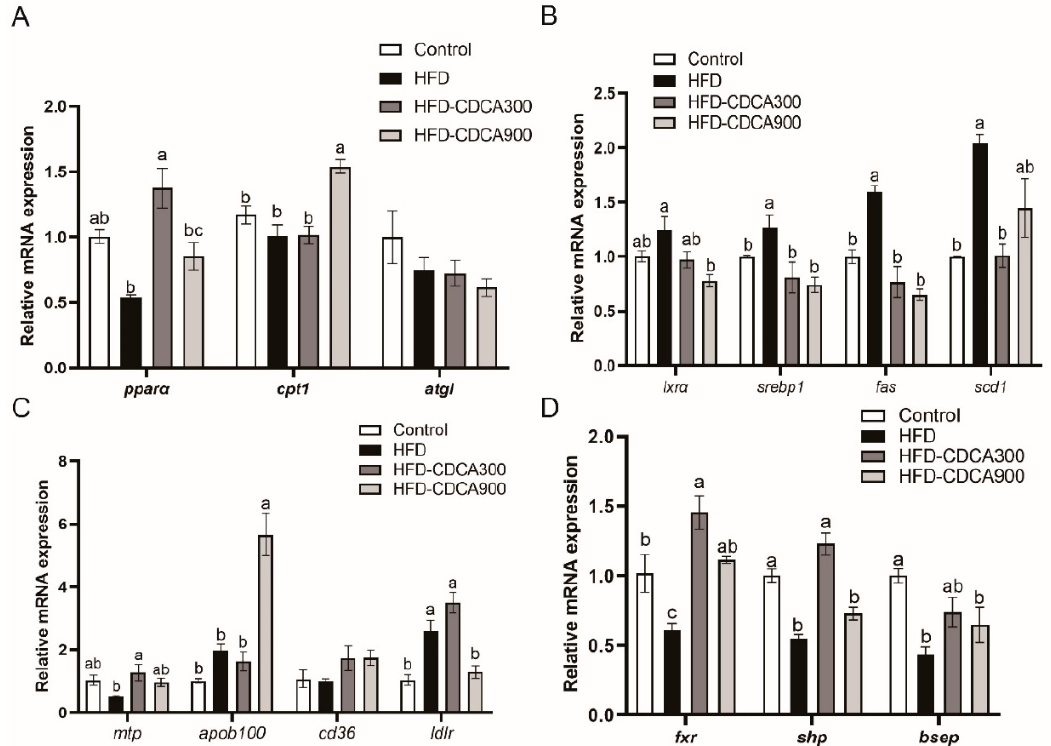
Figure 2. Effect of HFD and CDCA supplementation on expression of lipid metabolism related genes. Expression of genes involved in: ( A ) Lipolysis and β -oxidation; ( B ) lipogenesis; ( C ) transport. ( D ) Expression of fxr and target genes ( shp and bsep ). The data are provided as means ± SEMs ( n = 3) and were analyzed using Duncan’s multiple range test. The letters a–c indicate that there is a significant difference between means, p < 0.05.